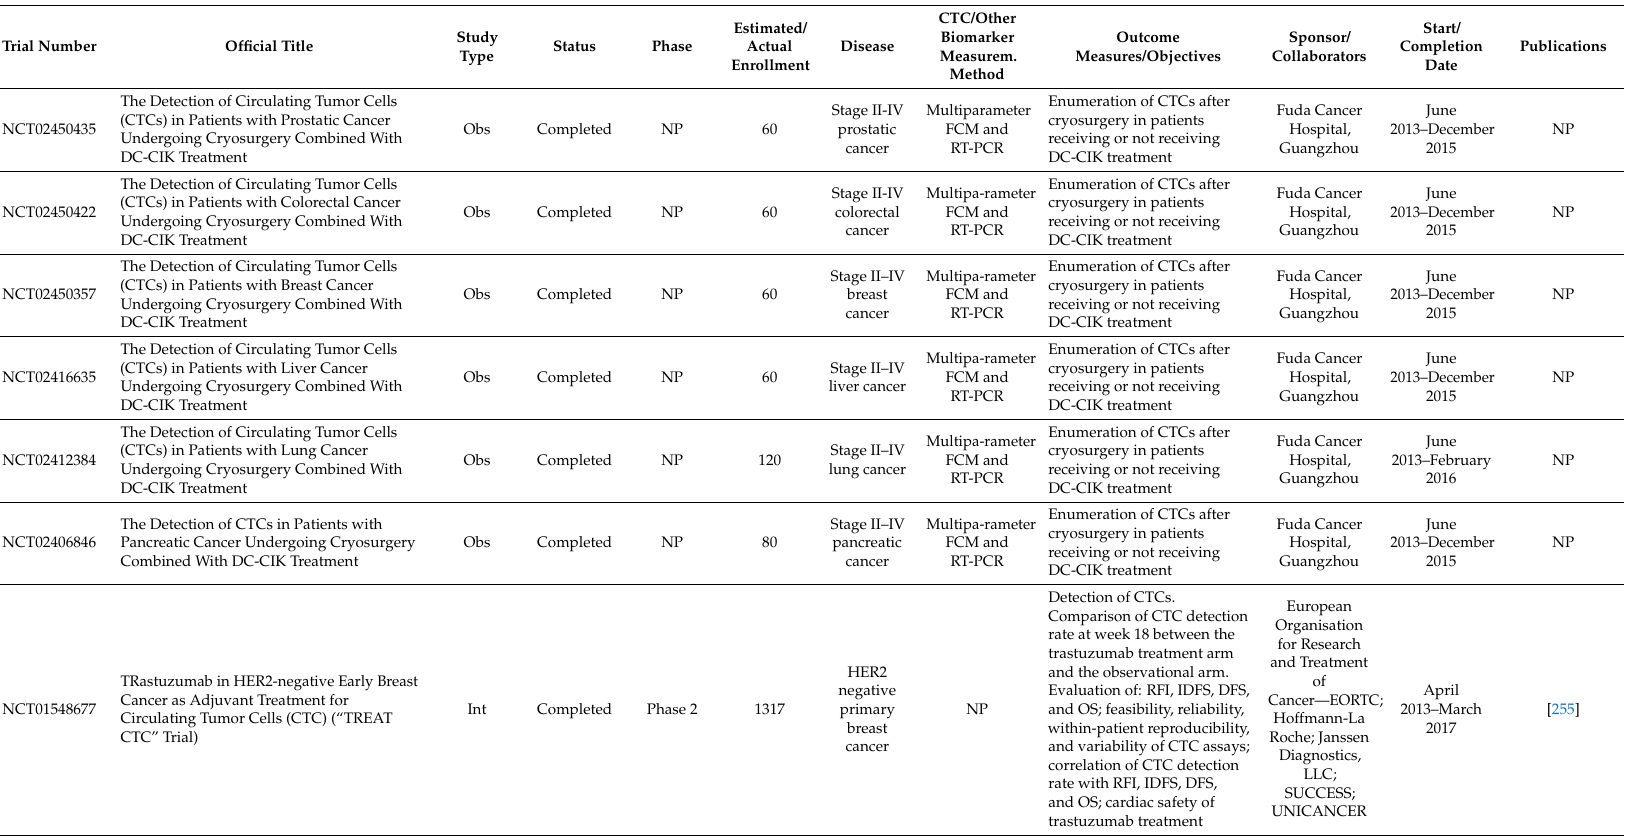
Detection of CTCs. Comparison of CTC detection rate at week 18 between the trastuzumab treatment arm and the observational arm. Evaluation of: RFI, IDFS, DFS, and OS; feasibility, reliability, within-patient reproducibility, and variability of CTC assays; correlation of CTC detection rate with RFI, IDFS, DFS, and OS; cardiac safety